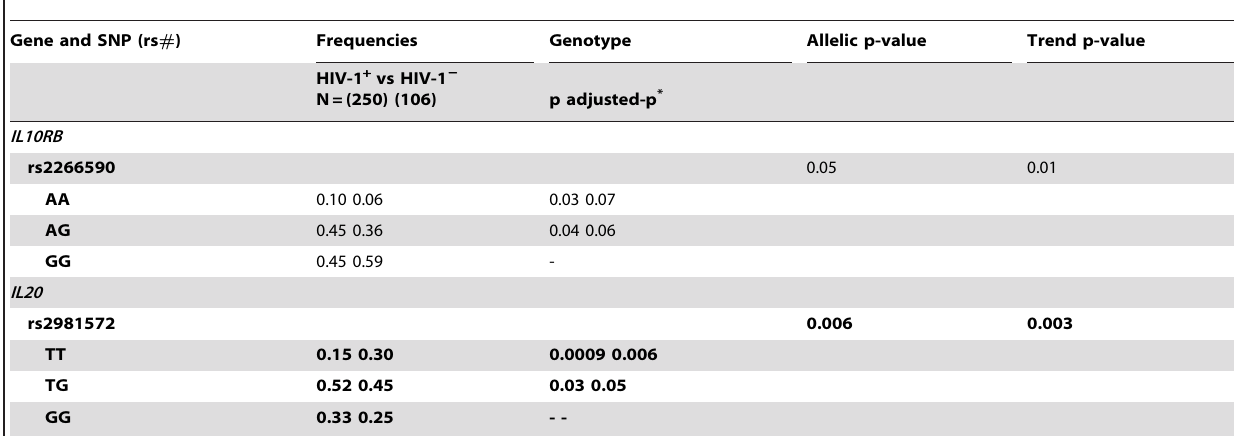
Table 1. Frequency distribution of genotypes in IL10 related genes between HIV-1 + and high risk HIV-1 2 adolescents.